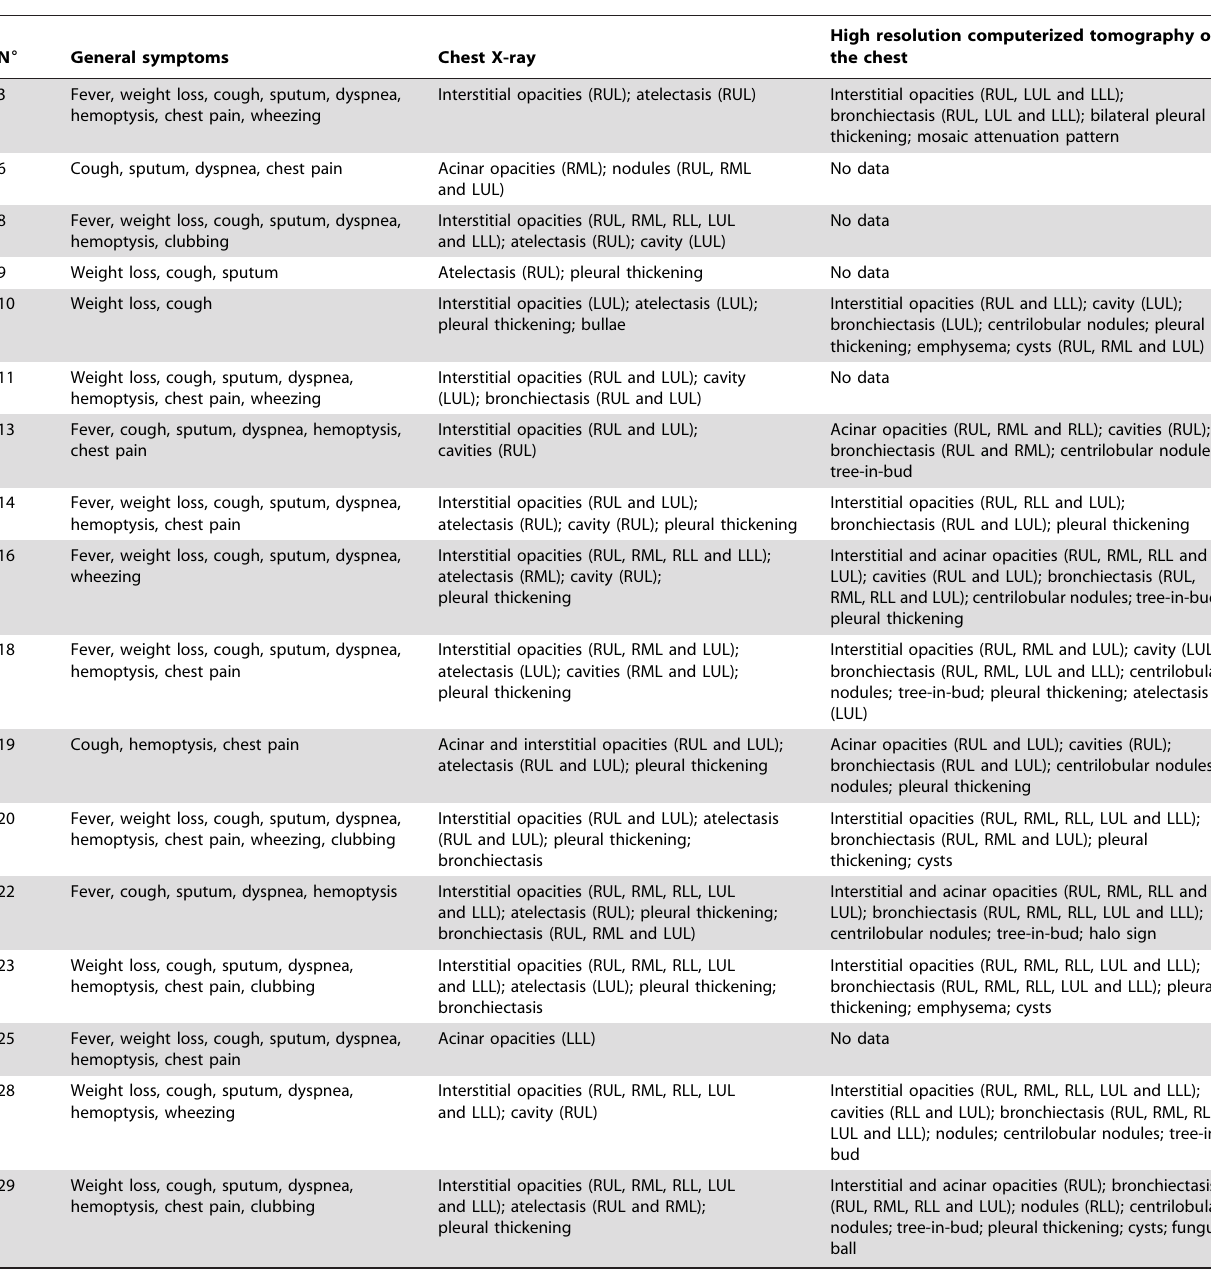
Table 3. Clinical and images findings for some nontuberculous mycobacterial pulmonary infected patients from Para State,